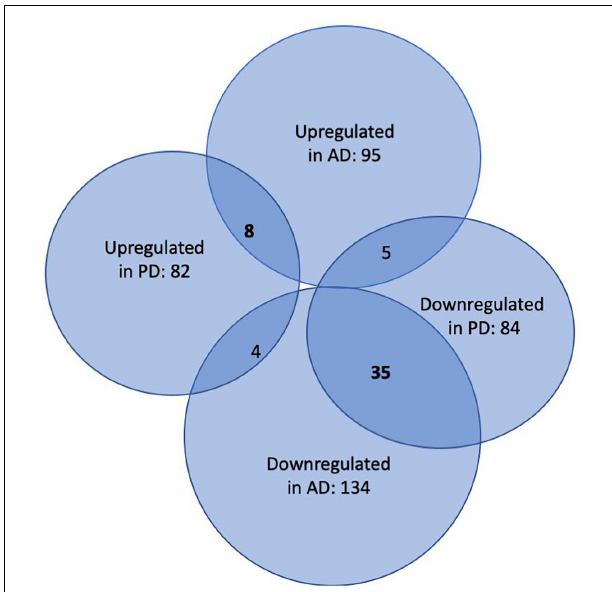
FIGURE 1 | Venn-Diagram of miRNAs being differentially expressed in patients suffering from AD and PD versus healthy controls. The overlaps summarize miRNAs being detected in both conditions.